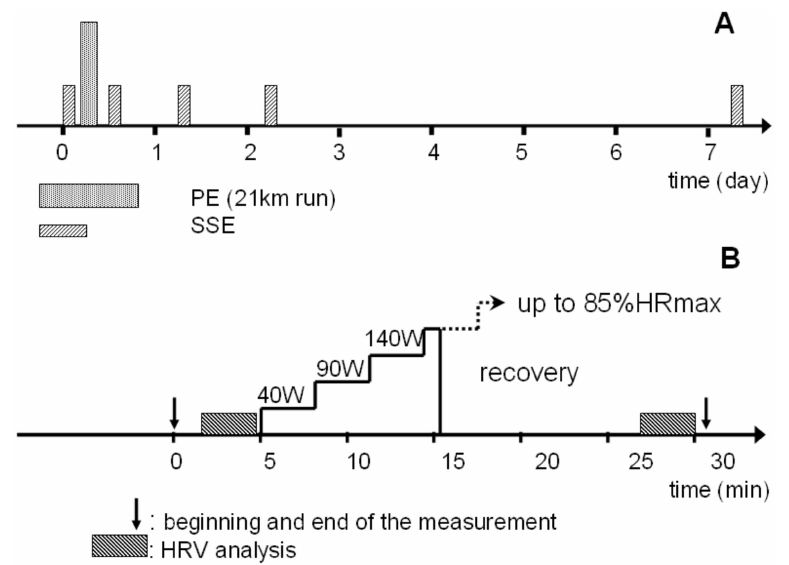
Figure 1. Overview of experimental trial protocol; ( A ) timeline of exercises performed by subjects; PE—prolonged exertion in the form of a half-marathon run; SSE—short-lasting submaximal exercise; ( B ) timeline of short-lasting submaximal cycling exercise; HRmax—maximal heart rate; HRV—heart rate